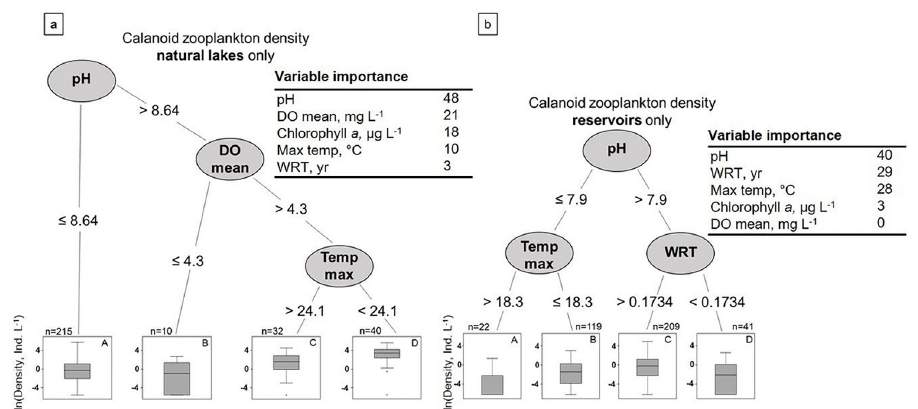
Fig 5. Regression tree analysis for calanoid zooplankton density conducted separately for a) natural lakes and b) reservoirs.